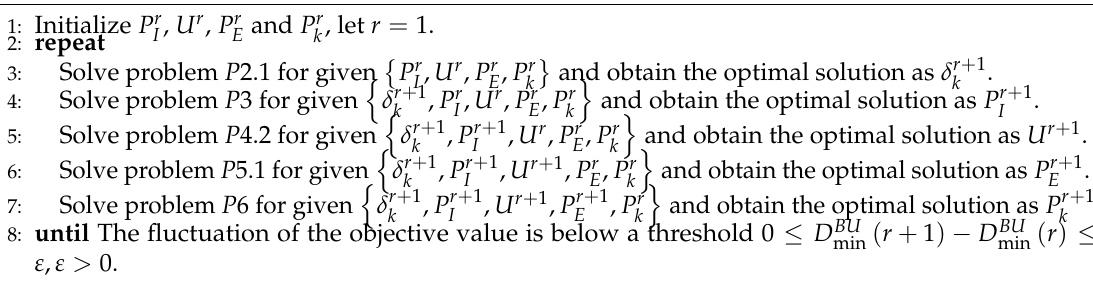
Algorithm 1 Successive Convex Optimization